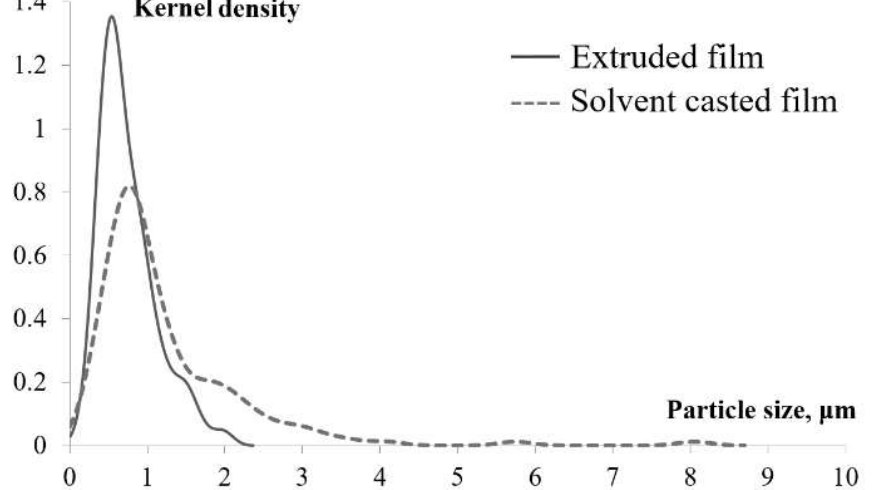
Figure 6. POM particle size distribution in solvent casted (dashed line) and extruded films (solid line).